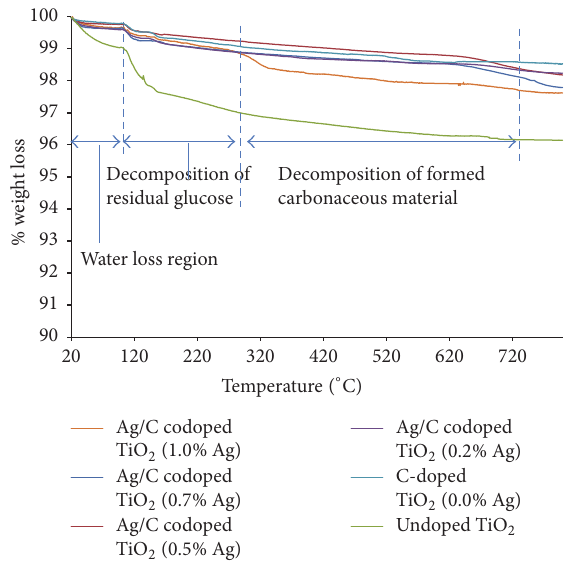
Figure8:ThermogramsofundopedTiO 2 ,C-dopedTiO 2 ,andAg/C codoped TiO 2 photocatalysts with different Ag contents.